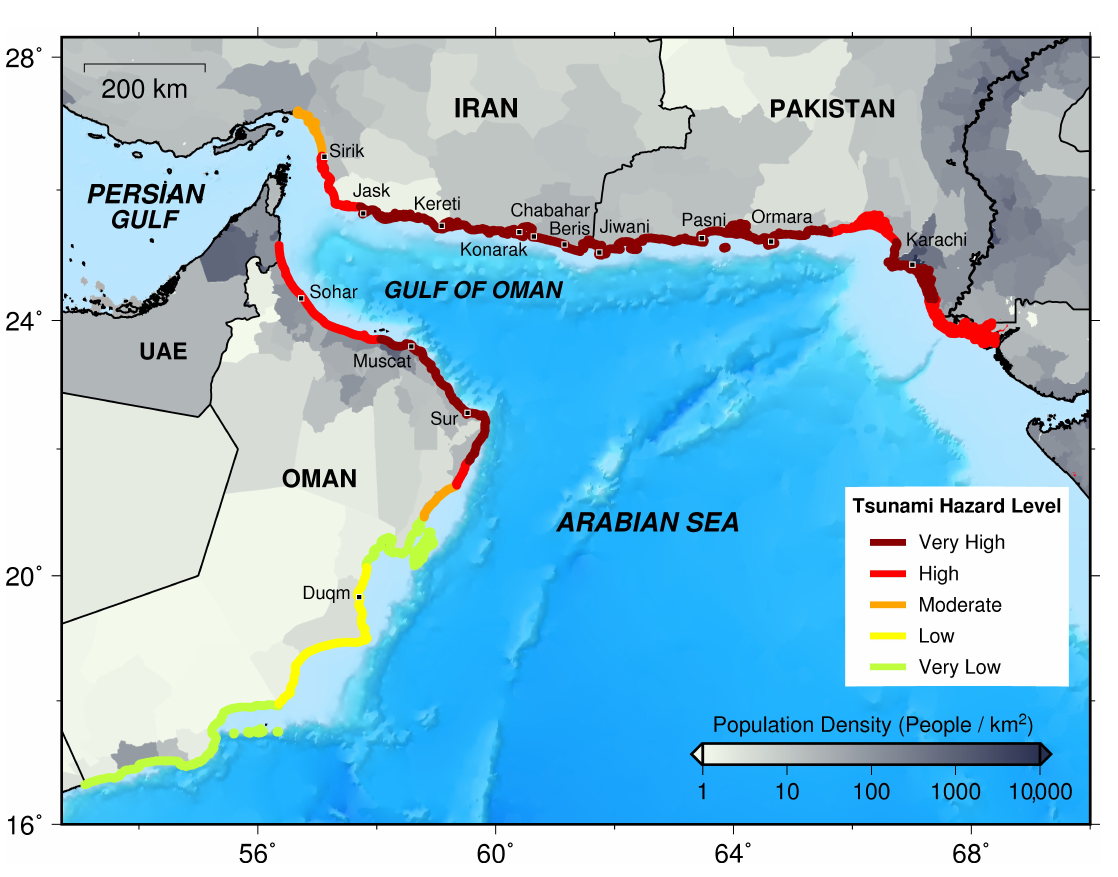
Figure 12. Population denisity [137,138] and tsunami hazard level along the coastlines of the Makran